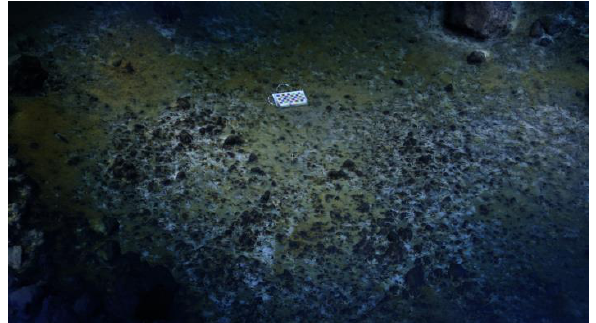
Figure 5. Ground truth model